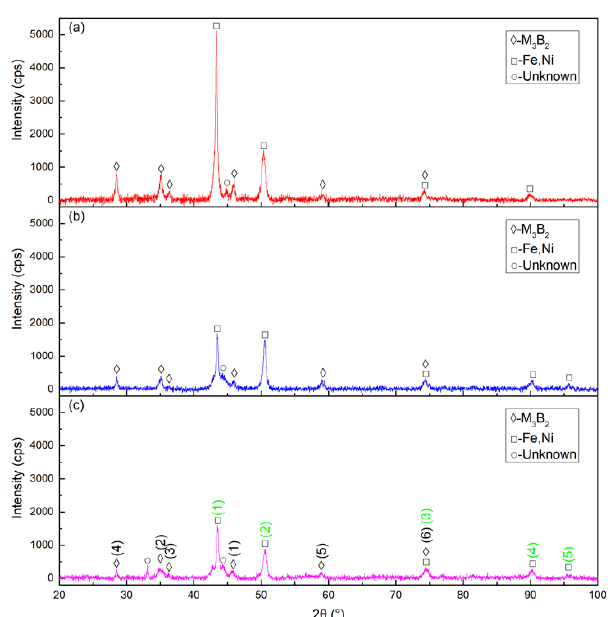
Figure 2. X-ray diffraction (XRD) patterns of the cermet coatings at various laser powers: ( a ) laser power of 2200 W; ( b ) laser power of 2500 W; ( c ) laser power of 2800 W.